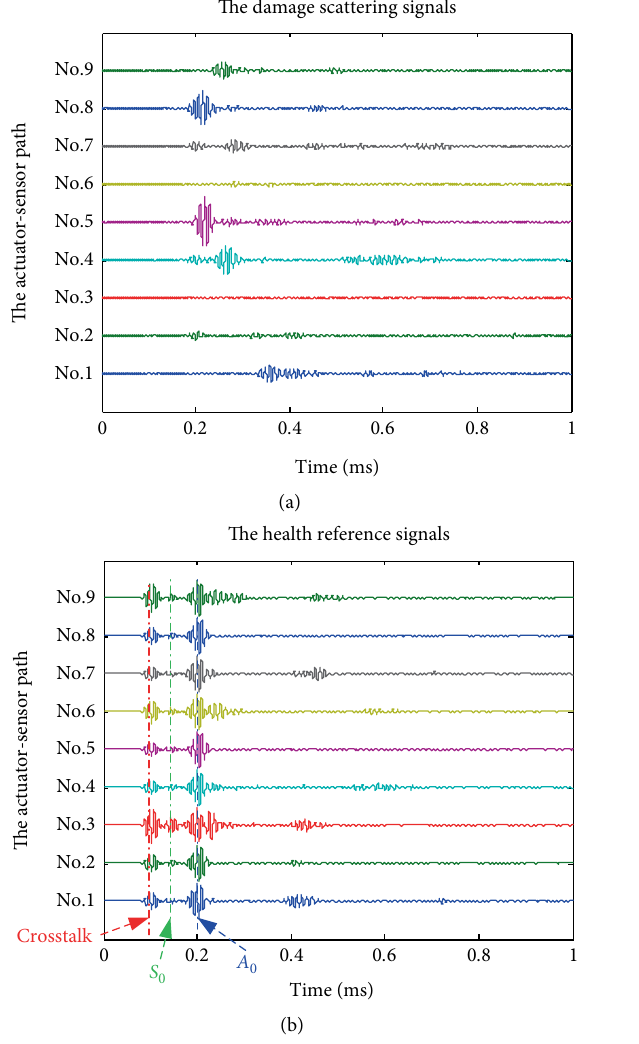
Figure 9: The damage scattering and health reference signals of a diagonal in each subarea. (a) The damage scattering signals; (b) the health reference signals.